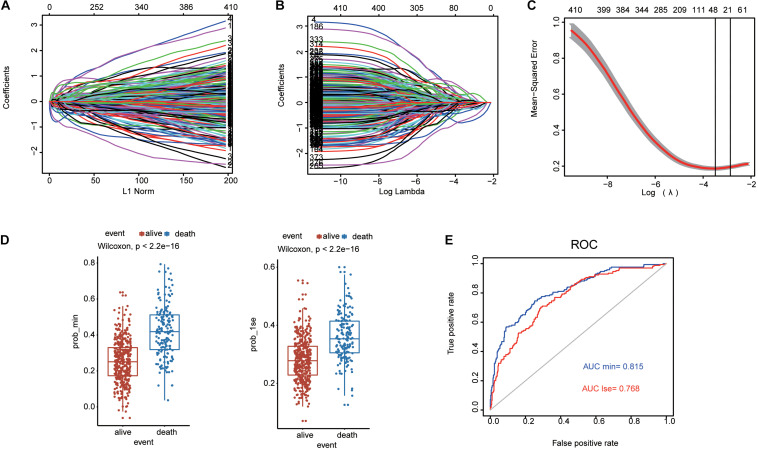
Lasso penalized Cox regression analysis of SE-associated 410 genes. (A,B) The coefficient values at varying levels of penalty. (C) The identification of best Lambda value. The left solid vertical line is the logarithm of lambda.min (35-gene group), the right solid vertical line is the logarithm of lambda.1se (13-gene group). (D) Two models based on lambda.lse and lambda.min are used to distinguish the survival and death events by the Wilcoxon test. (E) ROC curves are used to compare the predictive performance for prob-min and prob-1se to predict patient survival.